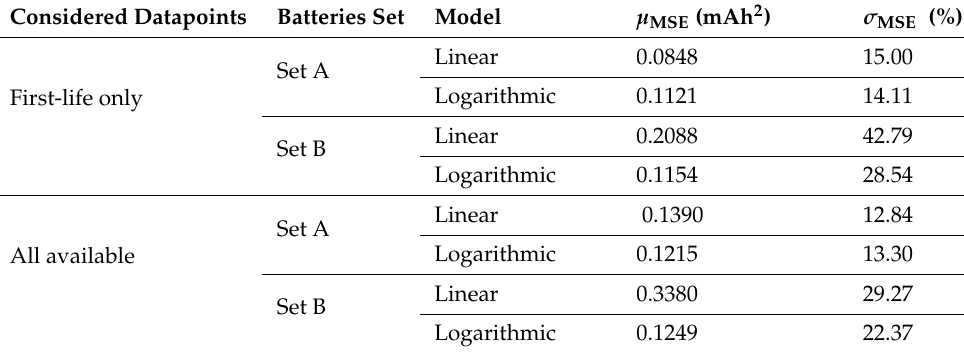
Table 5. Prediction average results for 10,000 random splits of data.